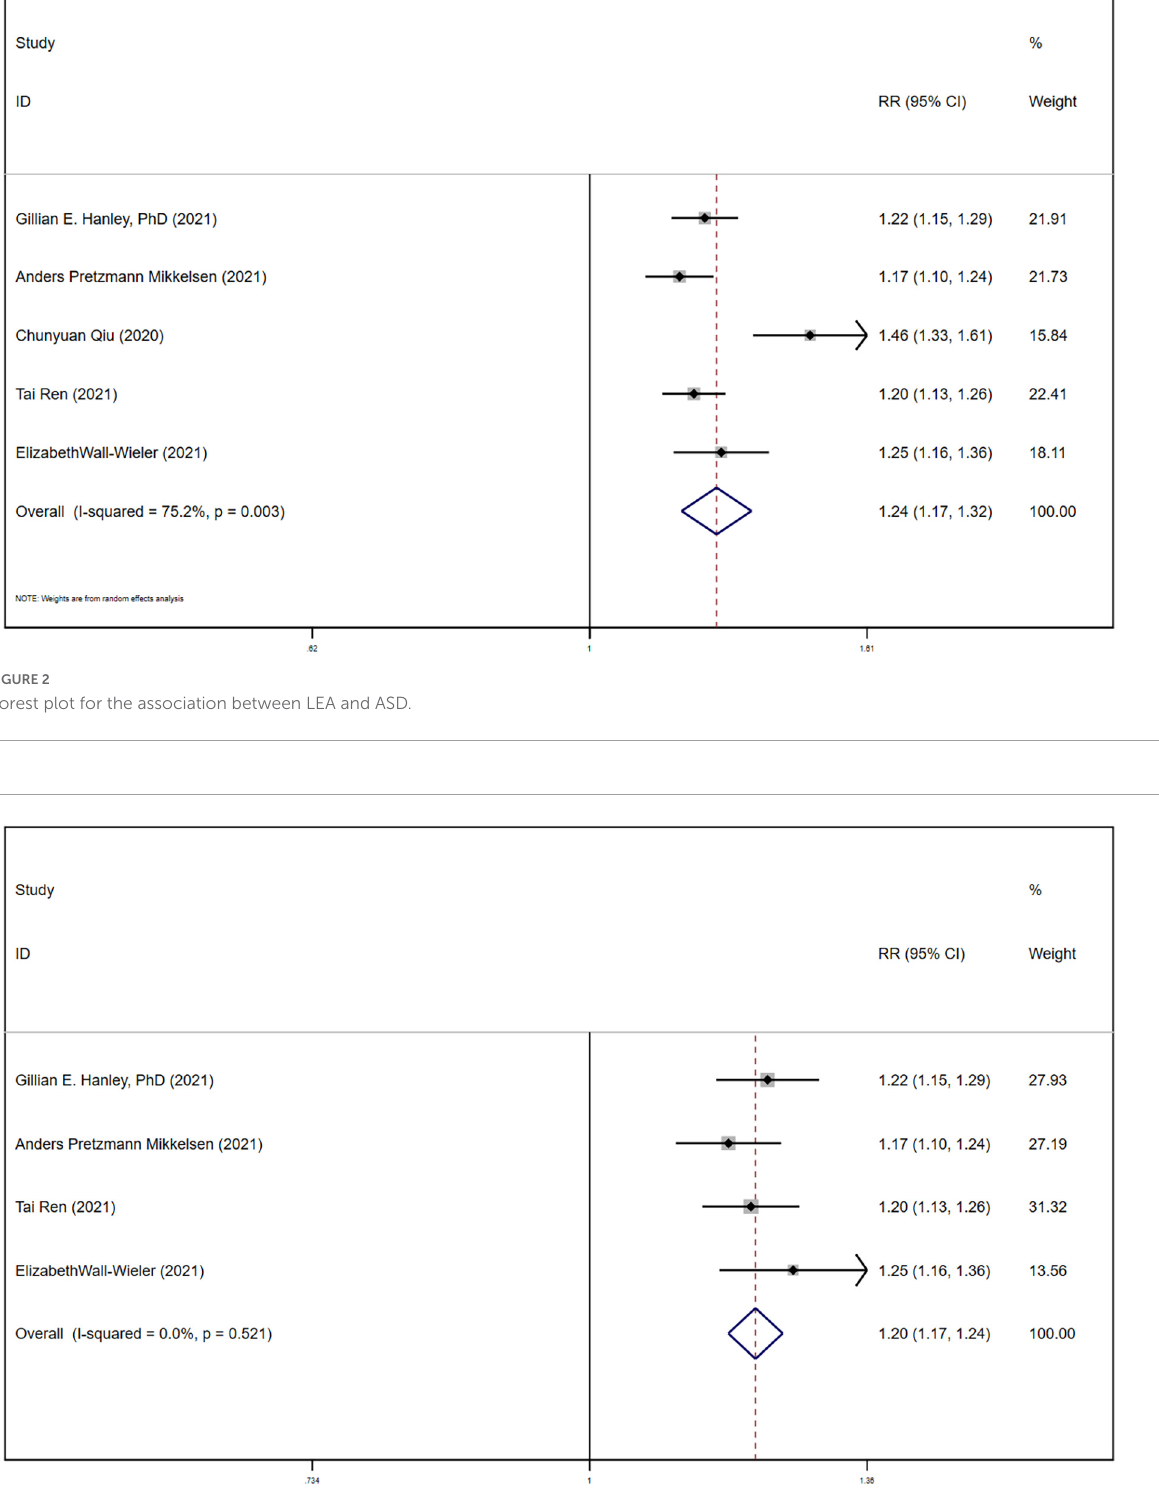
FIGURE3 Forest plot for association between LEA and ASD after removing